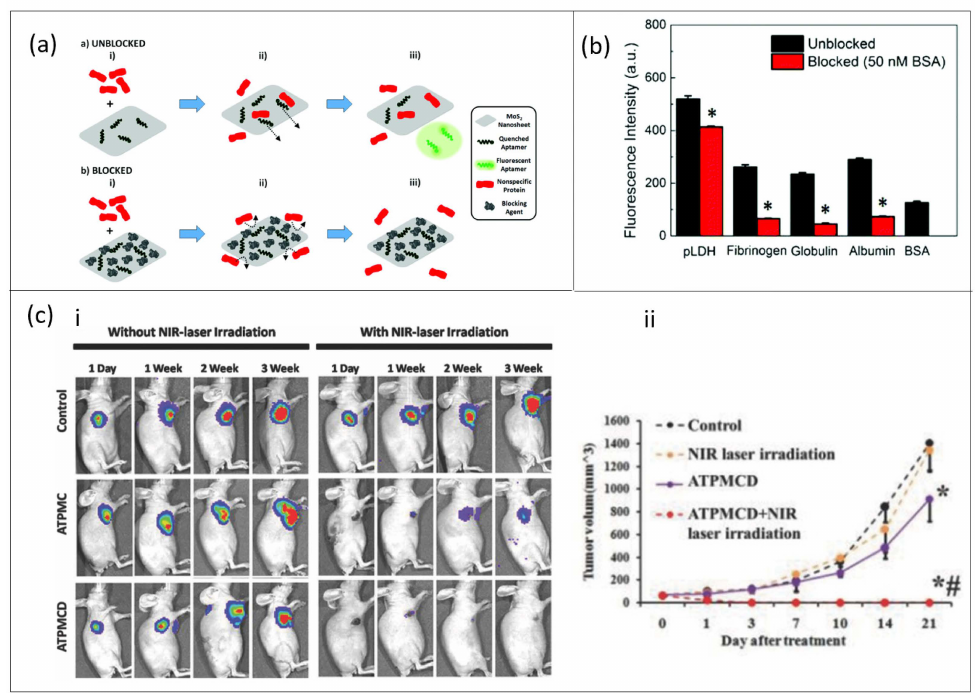
Figure 3. Strategy of enhancing sensing capabilities of MoS 2 -based aptasensors in medical diagnosis. ( a , b ) The effect of surface blocking on non-specific fluorescence recovery in a fabricated MoS 2 - based fluorescence resonance electron transfer (FRET) aptasensor and its corresponding effect on fluorescence intensity observed after the addition of protein to either an aptasensor in unblocked or blocked format. Adapted from Geldert et al. [86] with permission from Royal Society of Chemistry. ( c ) Therapeutic efficacy of ATPMC and ATPMCD in inhibiting cancer tumor growth. ( c - i ) Monitoring of tumor tissues following injection with physiological saline via signal intensity of noninvasive bioluminescent imaging (BLI). ( c - ii ) Tumor volumes calculated based on sizes of tumor tissues in mice after exposure to different treatment methods (* p < 0.01 compared with control; # p < 0.01 compared with ATPMCD group). Adapted from Meng et al. [87] with permission from Wiley